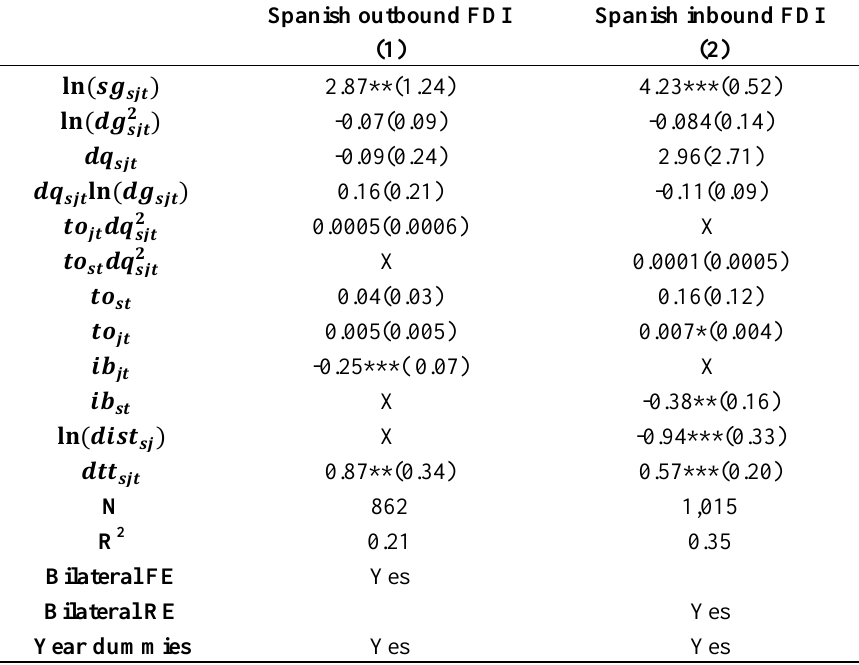
Table 2 : Effect of DTTs on Spanish inbound and outbound FDI: Overall